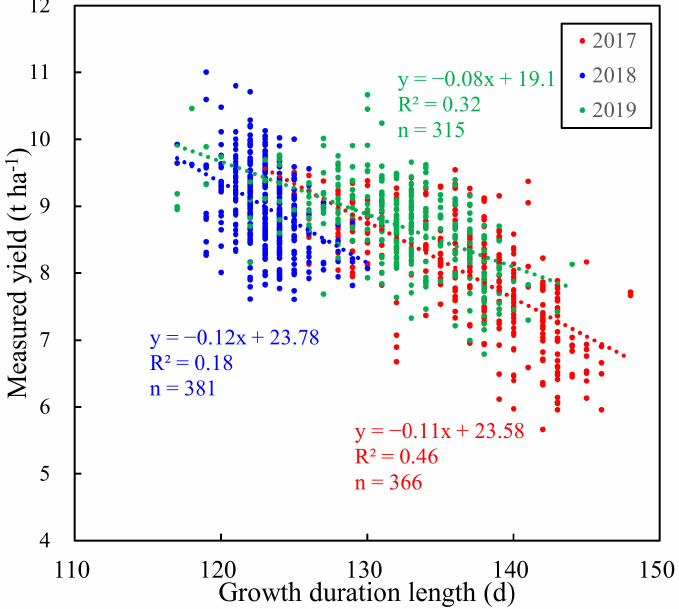
Figure 2. The relationship between measured yield and GDL for all cultivars in 2017 (366 plots and 122 cultivars), 2018 (381 plots and 127 cultivars), and 2019 (315 plots and 105